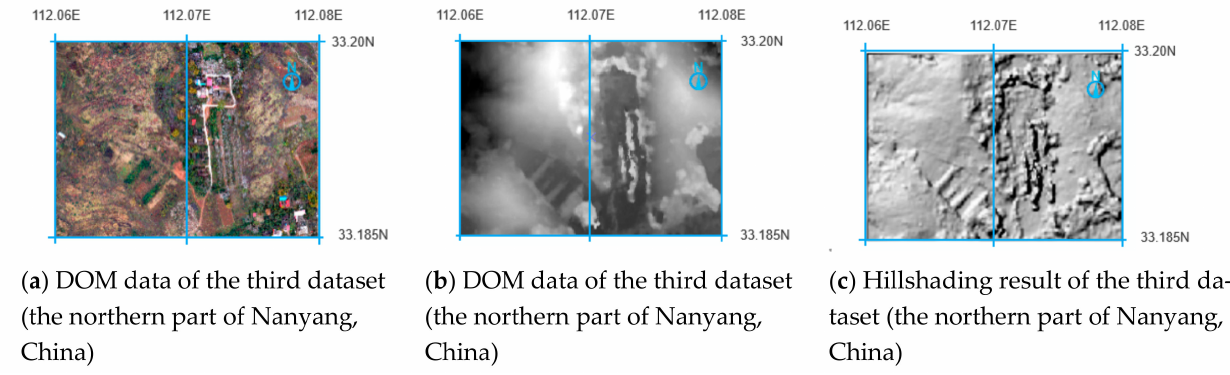
Figure 16. The third dataset: ( a ) DOM data of the third dataset (the northern part of Nanyang, China); ( b ) DEM data of the third dataset (the northern part of Nanyang, China); ( c ) Hillshading result of the third dataset (the northern part of Nanyang,